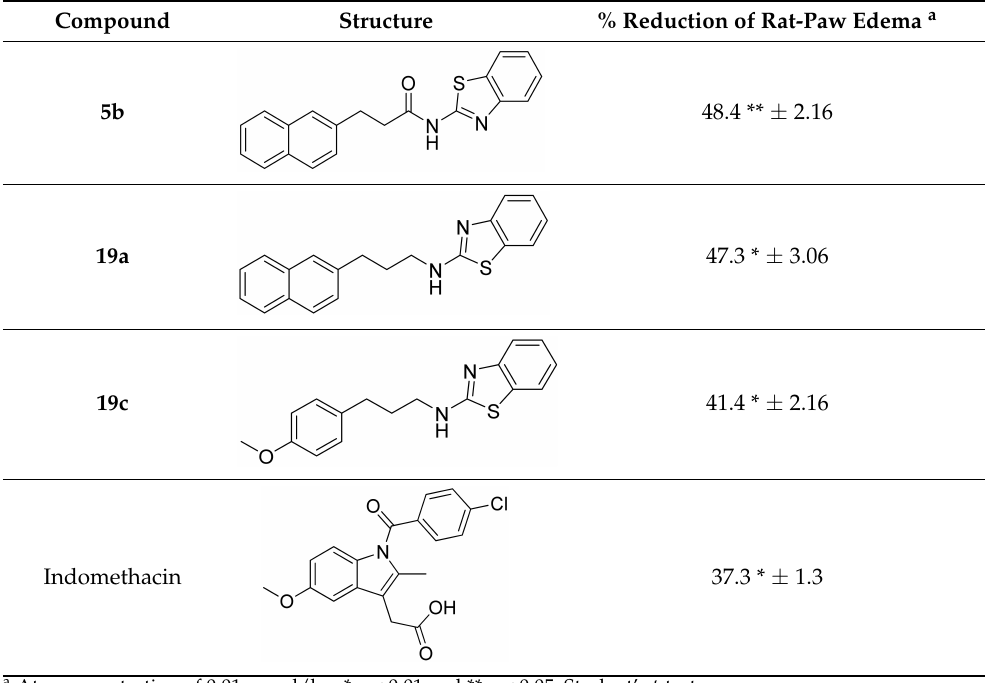
Table 3. In vivo anti-inflammatory activity of selected benzothiazole